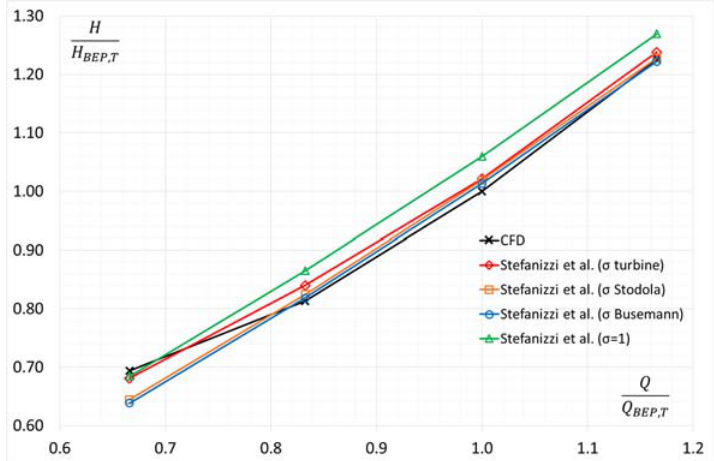
Figure 8. Comparison of different slip factor definitions (i.e., σ turbine , σ proposed by Busemann [8], σ proposed by Stodola [9] and σ = 1 ) with the CFD